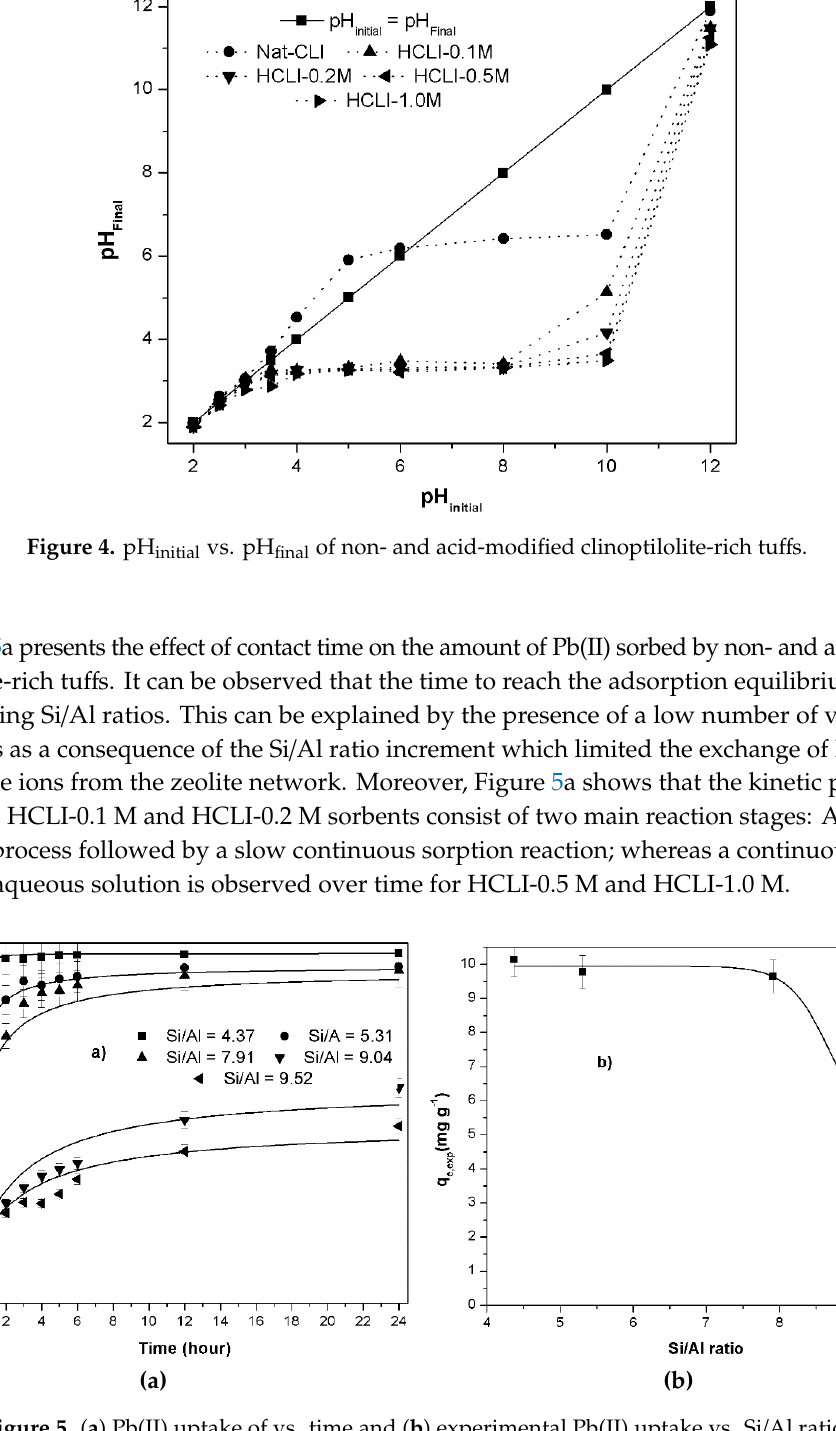
Figure 5. ( a ) Pb(II) uptake of vs. time and ( b ) experimental Pb(II) uptake vs. Si/Al ratio.